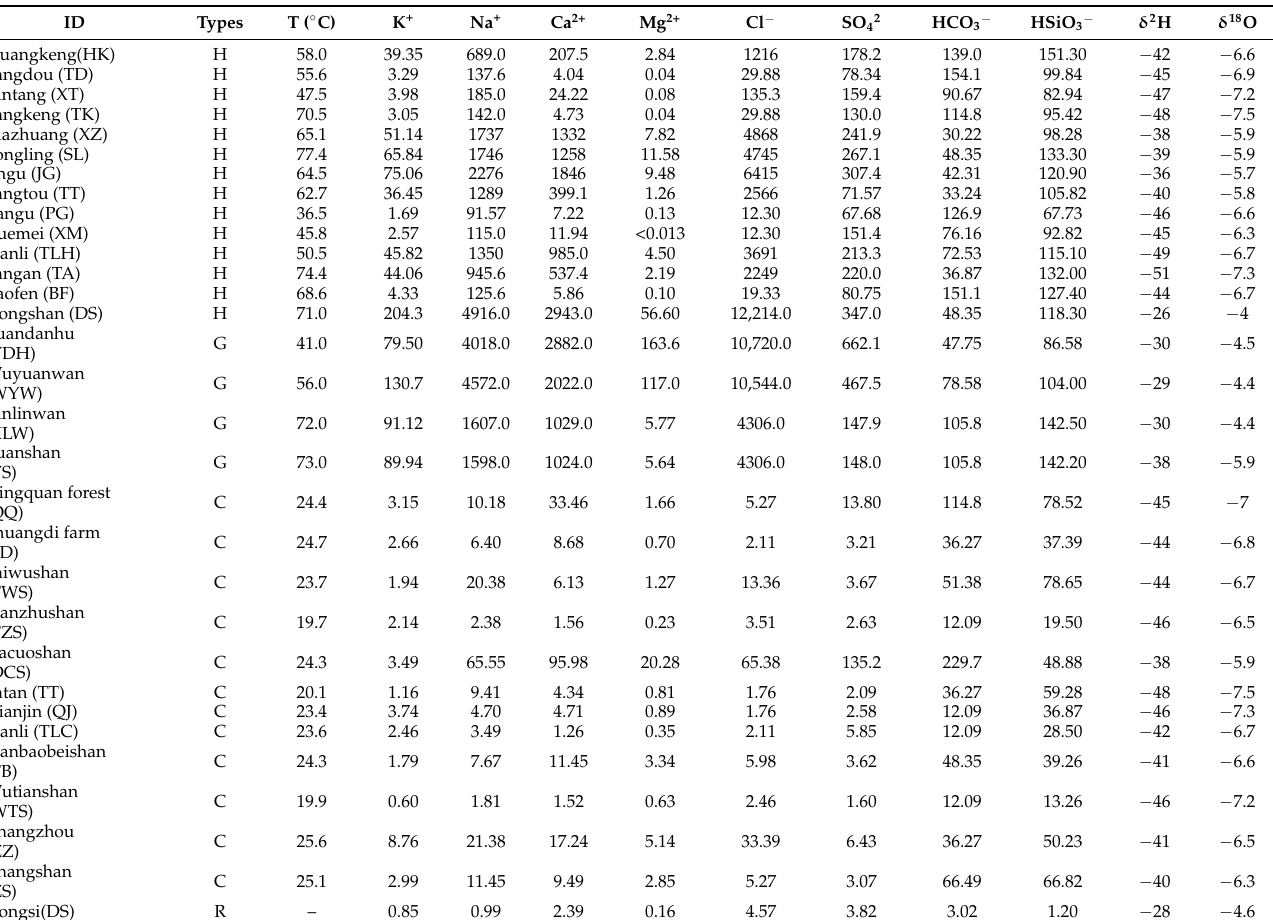
Table 1. Hydrochemical characteristics of the sampling